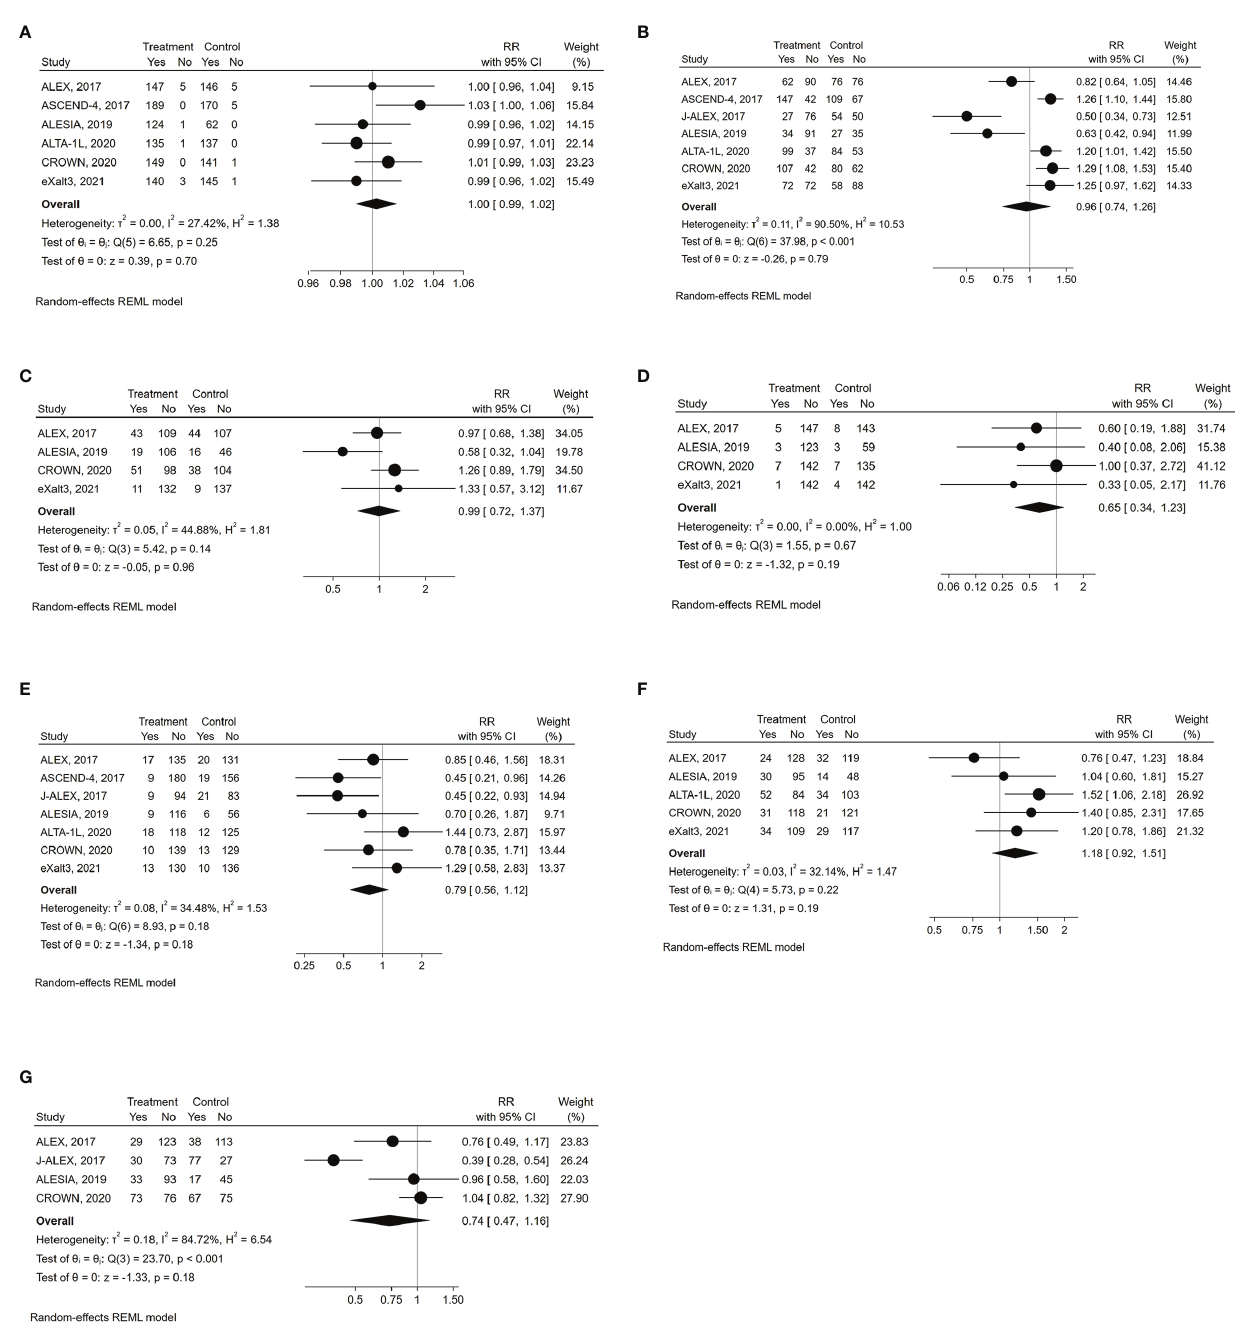
FIGURE 4 | Forest plots of RR (relative risk) for safety outcomes associated with next-generation ALKIs compared to control therapies. (A) all grade AEs (adverse events). (B) G3-4 AEs. (C) SAEs (serious adverse events). (D) fatal AEs. (E) drug discontinuation due to AEs. (F) dose reduction due to AEs. (G) dose interruption due to